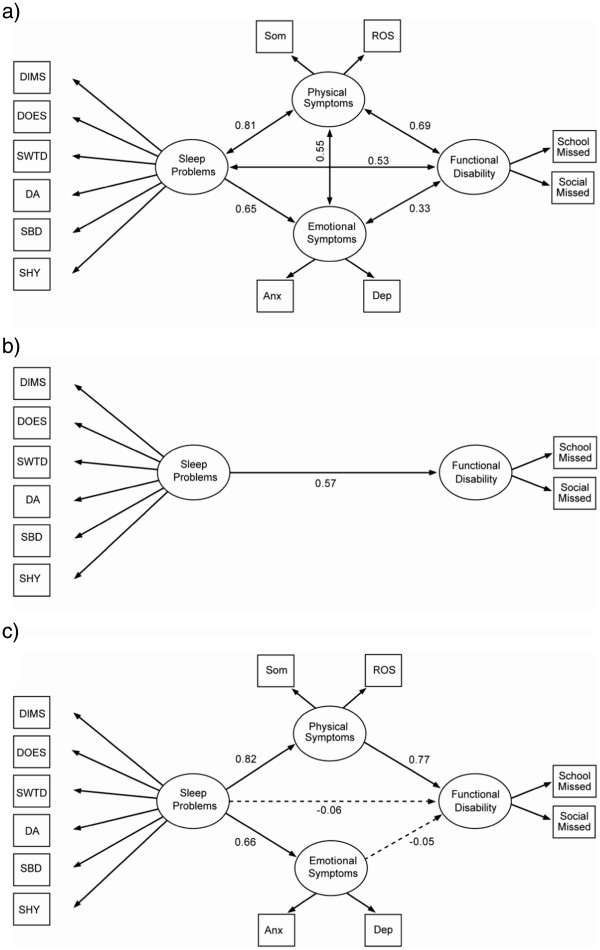
Three major theoretical models. Theoretical models: a. M1. Correlational model (χ2, p=0.18, good model fit). b. M2. Simple model (χ2, p=0.24, good model fit). c. M3. Causal model (χ2, p=0.24, good model fit). Note. Paths with significant partial regression coefficient or correlation coefficient (p<0.05) represented by solid lines; non-significant paths represented by dashed lines.